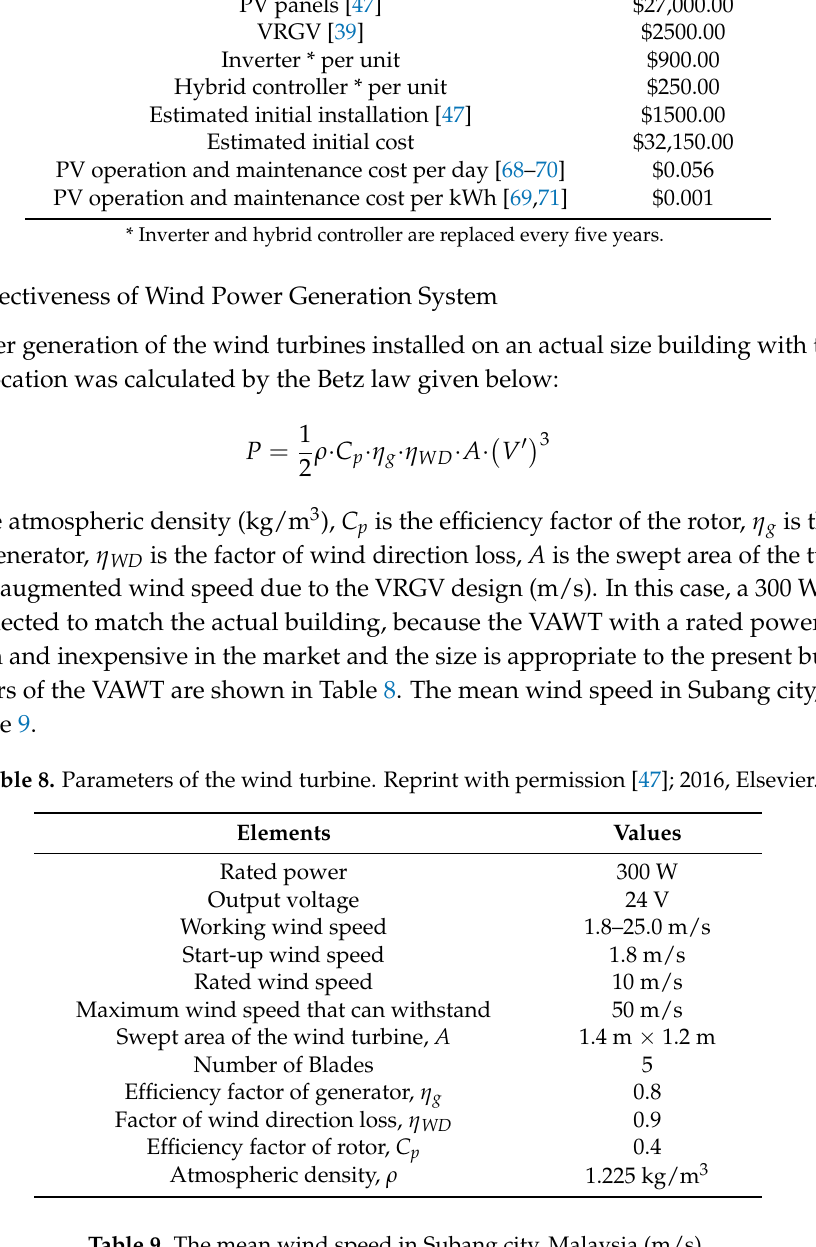
Table 9. The mean wind speed in Subang city, Malaysia